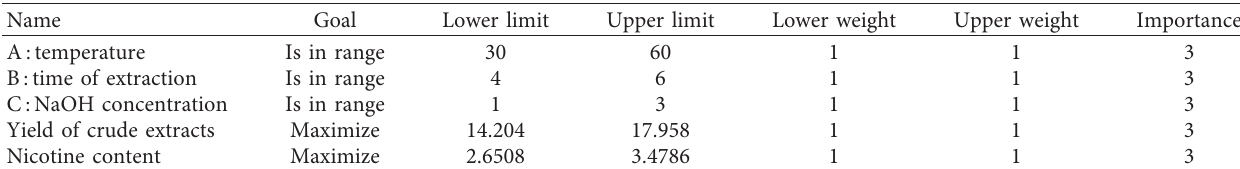
Figure 7: Ramp plot of optimization condition. Table 8: Constraints of